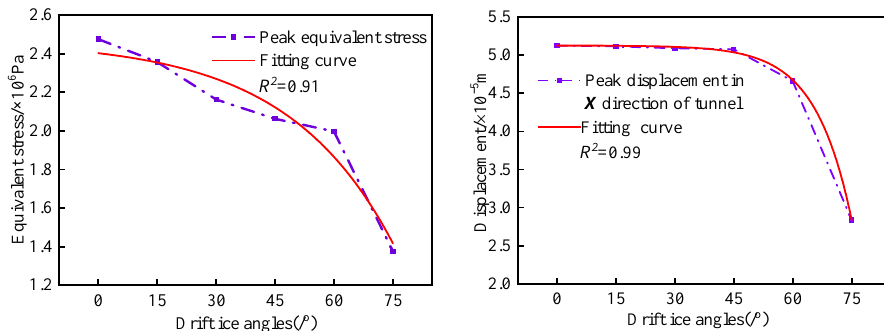
Figure 12. Peak graph of Equivalent stress ( left ) and X -direction displacement ( right ) for different collision angles.